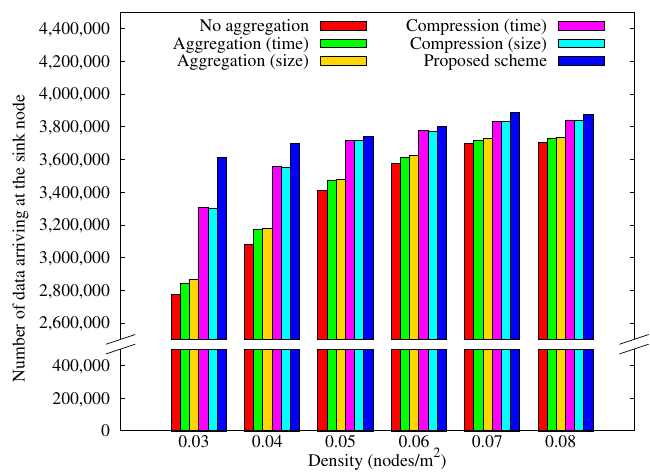
Figure 14. Change in the amount of data arriving at the sink node with node density (greedy perimeter stateless routing